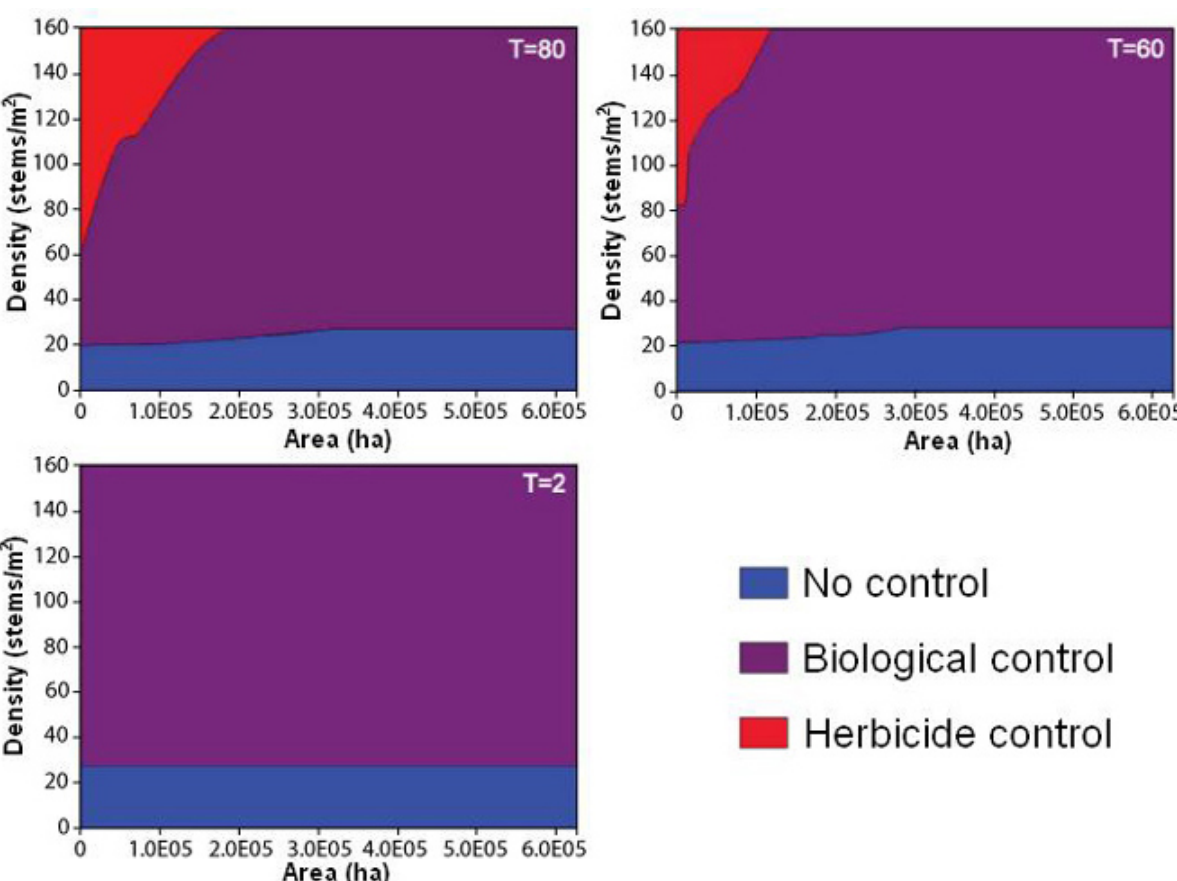
Fig. 2. The optimal control strategy to be applied for a given state (area of infestation in hectares) and density (stems of leafy spurge per square meter) using the stochastic dynamic programming solutions for three time horizons. The time horizons were selected to demonstrate the appearance of herbicide control as an optimal strategy at long time